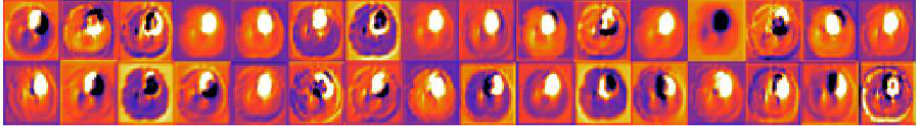
Figure 5. Features extracted from the last convolution layer of our CNN model. An image gradient quantifies a directional variation of intensity or color in an image.